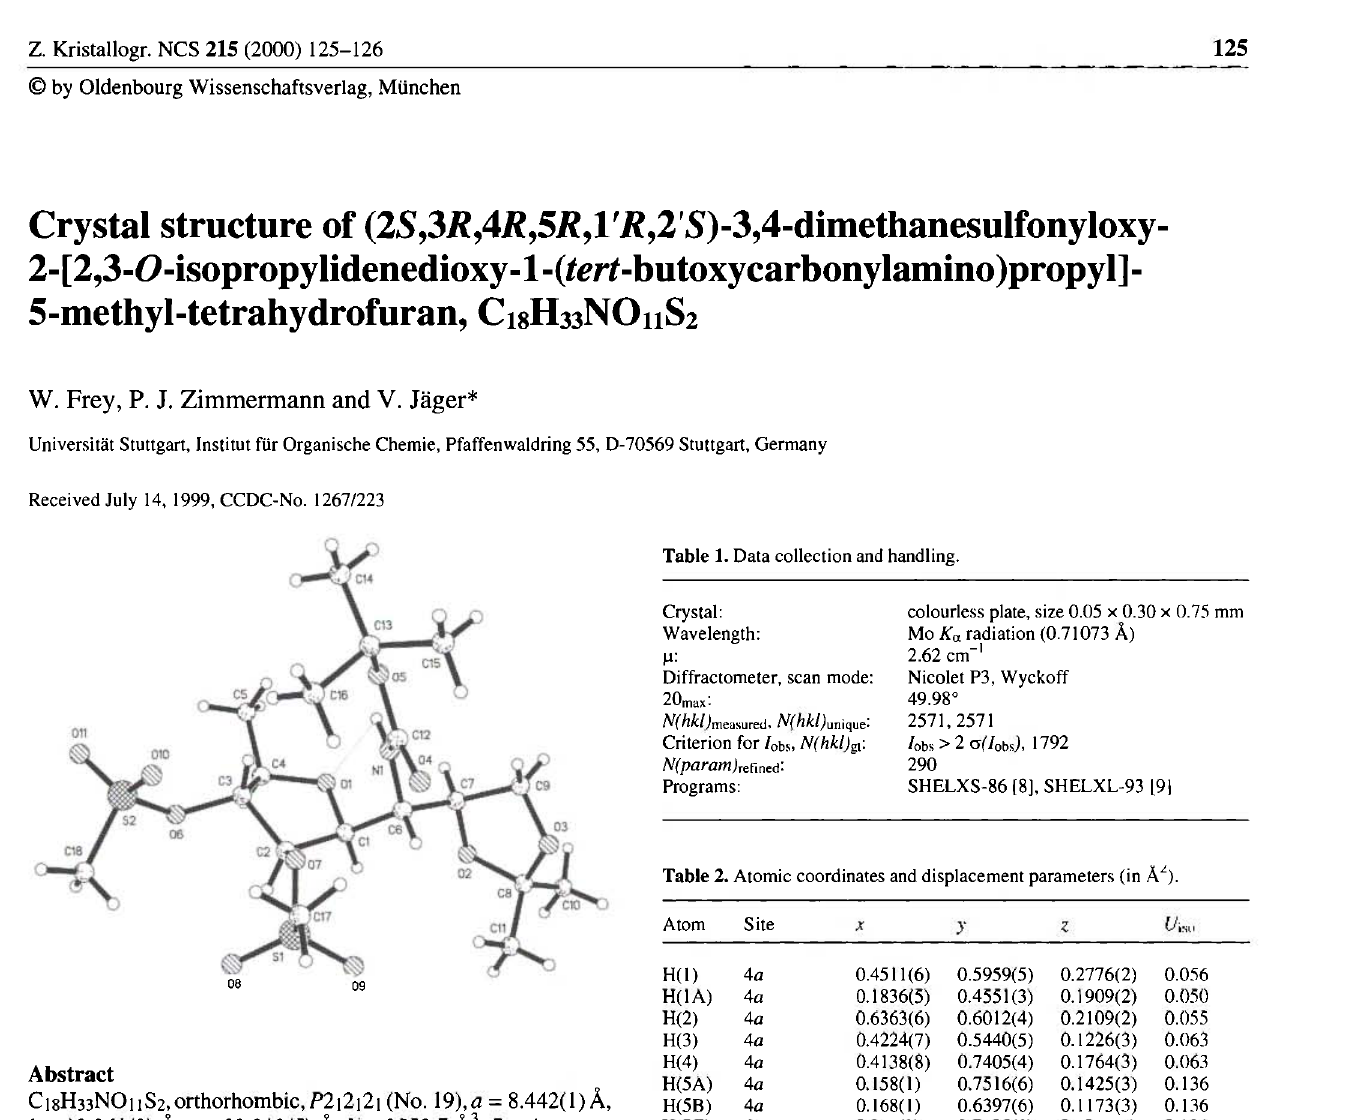
Table 2. Atomic coordinates and displacement parameters (in Ä